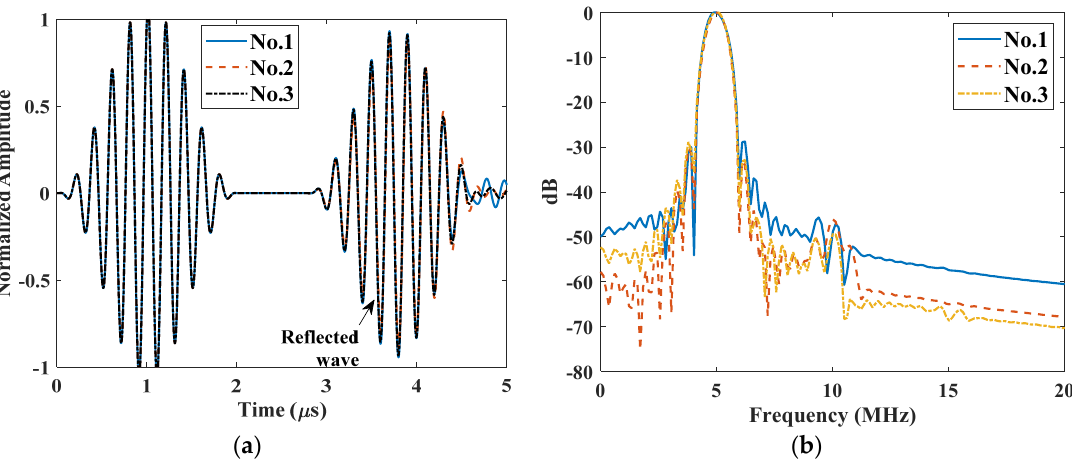
Figure 11. Three typical signals from the pulse-echo mode for the same rough surface ( R q = 50 µ m): ( a ) A-scan waveforms and ( b ) the spectra of the reflected waves.